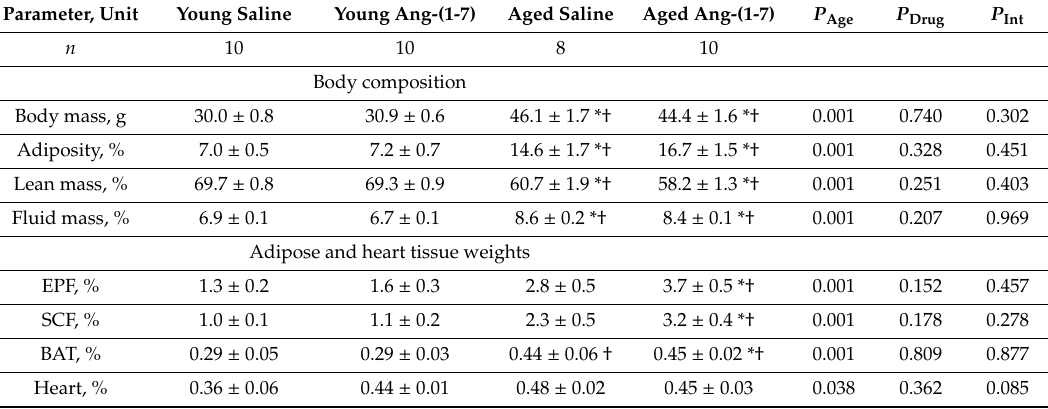
Data are mean ± SEM and were analyzed by two-way ANOVA for main e ff ects of age ( P Age ) and Ang-(1-7) versus saline treatment ( P Drug ) as well as their interaction ( P Int ) in young adult and aged mice. * p < 0.05 versus young saline and † p < 0.05 versus young Ang-(1-7) from post-hoc pairwise comparisons with Tukey correction for multiple comparisons. Body composition measurements and adipose and heart tissue weights are expressed as a percentage of total body mass. EPF, epididymal visceral white adipose tissue; SCF, inguinal subcutaneous white adipose tissue; BAT, interscapular brown adipose tissue.